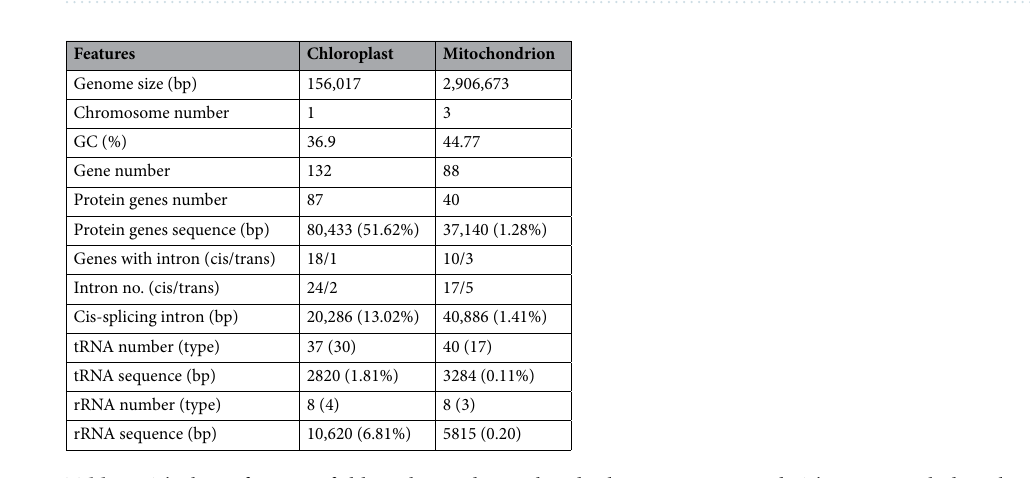
Table 4. The basic features of chloroplast and mitochondrial genomes in C. melo. The count excluding the gene duplicates. The note is applicable only to the numbers mentioned in brackets for features tRNA number and rRNA